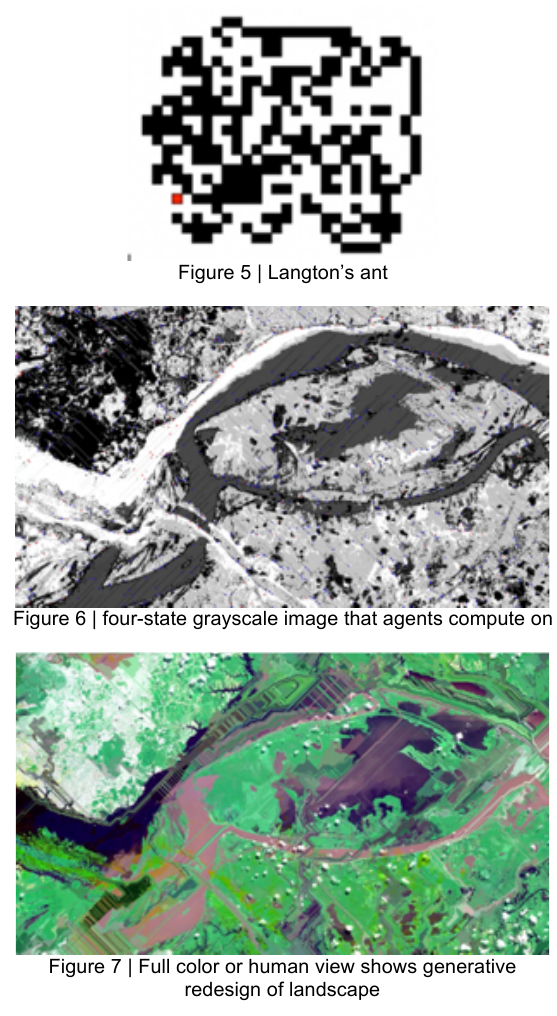
Figure 8 | OpenCV library example of background